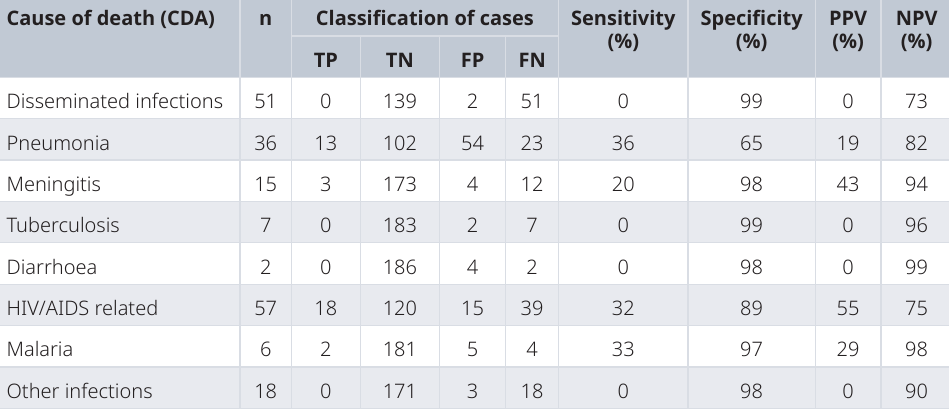
Table 3. Performance of the InterVA (Interpreting Verbal Autopsy) model at individual-level prediction among all cases who died of infectious diseases according to the complete diagnostic autopsy. Cause of death (CDA) n Classification of cases Sensitivity (%) TN FN Disseminated infections 51